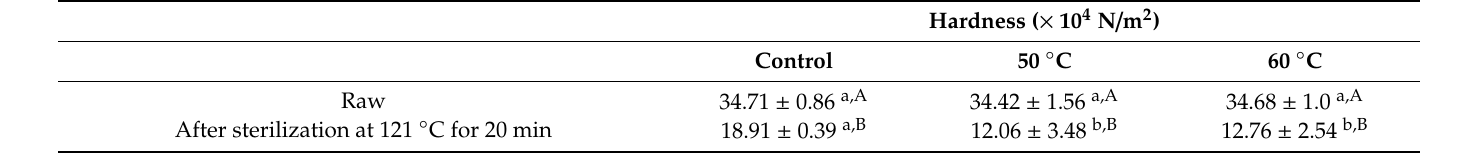
Table 5. Hardness of neritic squid muscle rehydrated at two temperatures after hot-air drying.